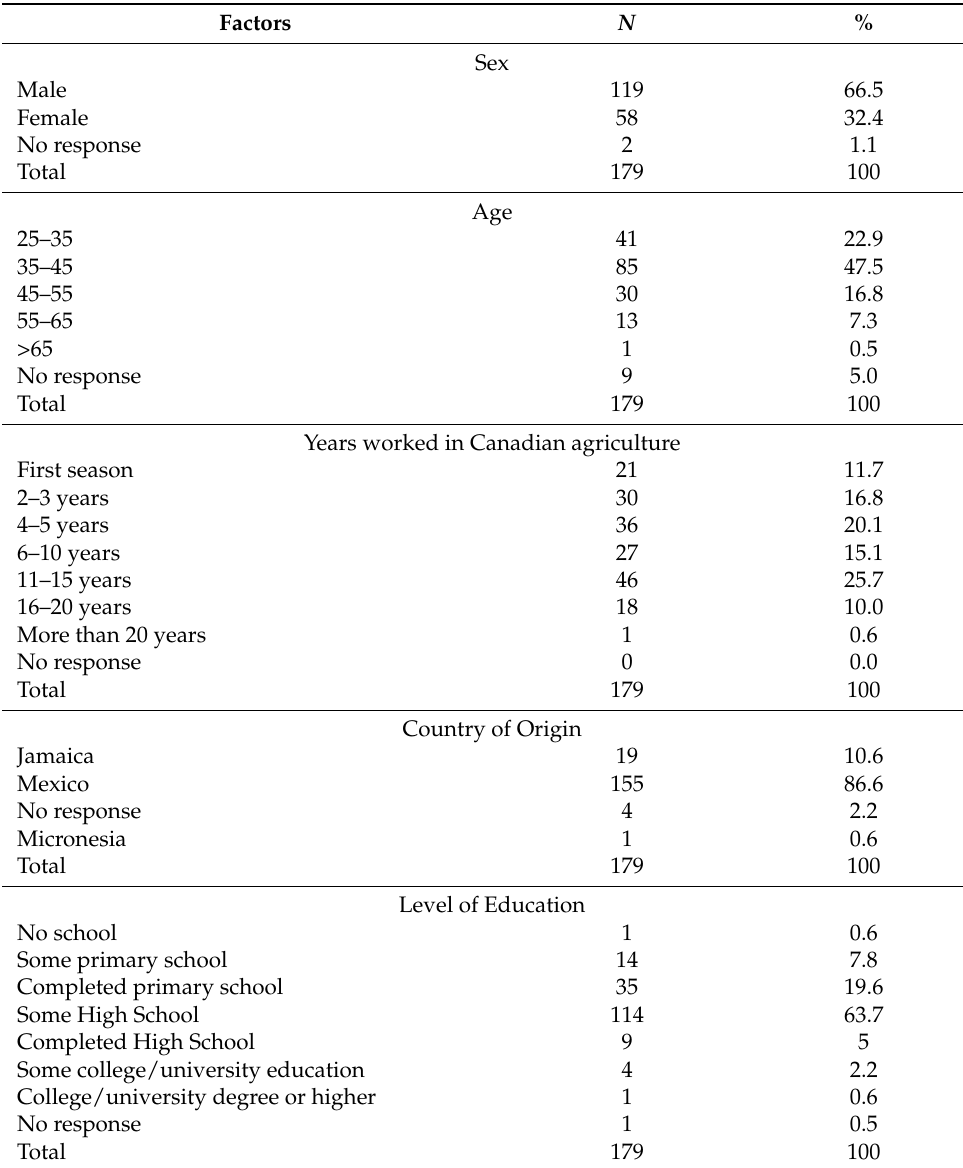
Table 1. Demographic